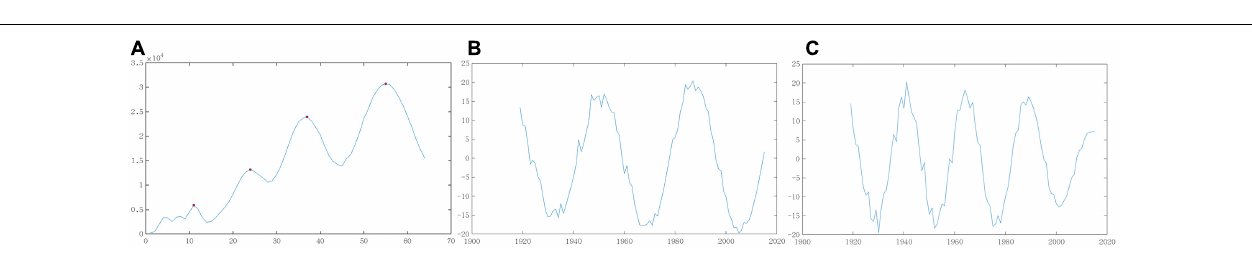
FIGURE 5 | Variance and periodic map of wavelet coefficients. (A) Wavelet variance. (B) The first cycle. (C) The second